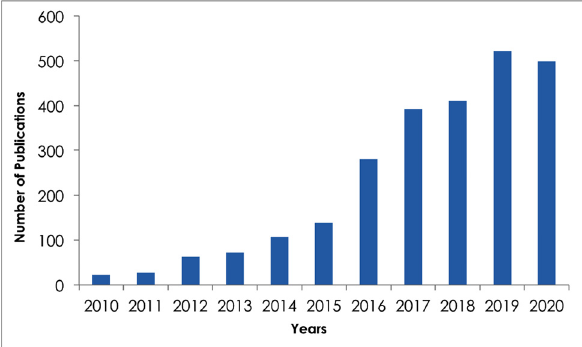
Figure 1: Number of publications of Graphene in AMC between years 2010 – 2020 based on Web of Science